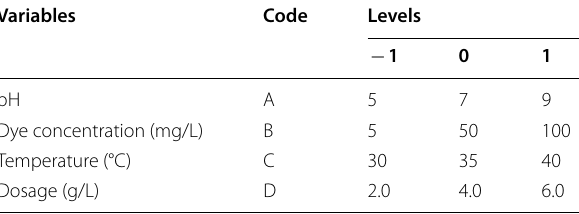
Table 2 Experimental range and levels of input process variables assessed